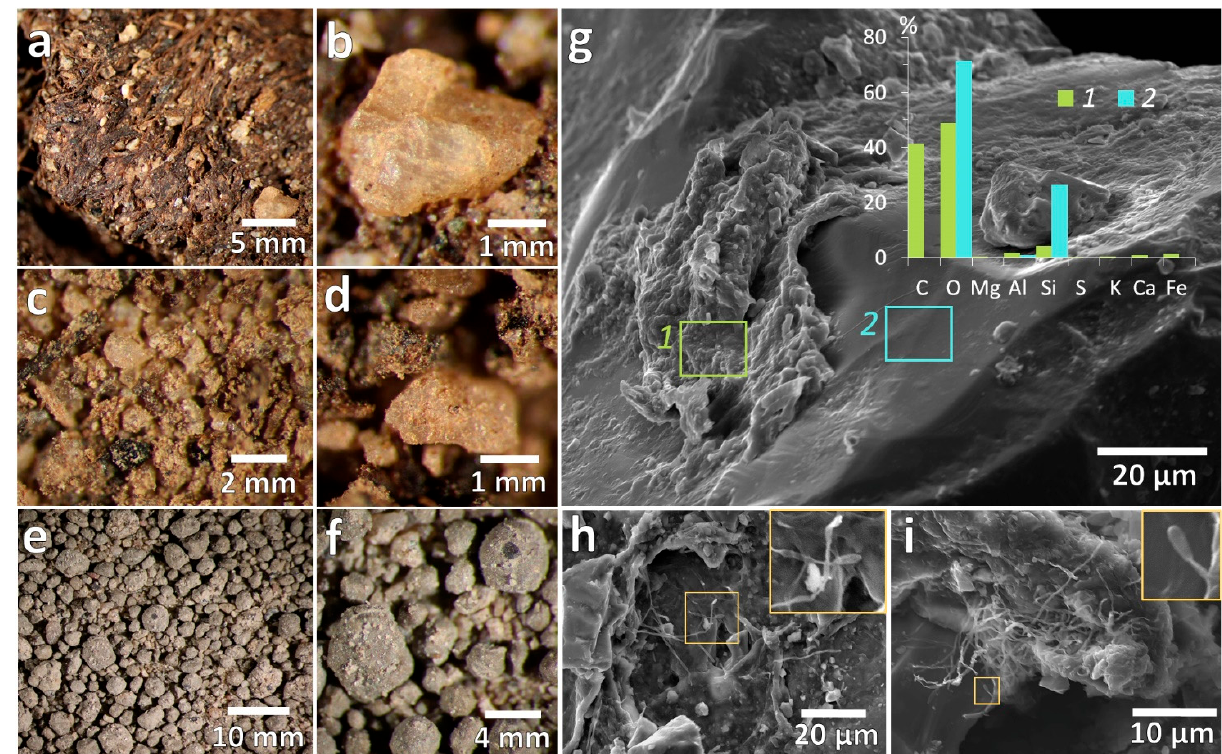
Figure 2. Morphology of intact soil samples under reflected light ( a , b )—Horizon AT from BB 63-58 soil profile; ( c , d )—Horizon AB from BB 63-58 soil profile; ( e , f )—Sample from BB 63–48 soil profile) and Scheme 63. soil profile ( g – i ). Abundances of elements shown at ( g ) correspond to organo-mineral film (region of interest “1”) that covers quartz grain (region of interest “2”).